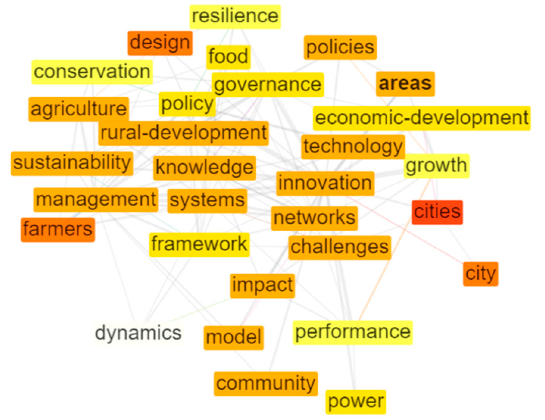
Figure 3. Co-occurrence map of the most frequently used terms in the abstract of the papers.